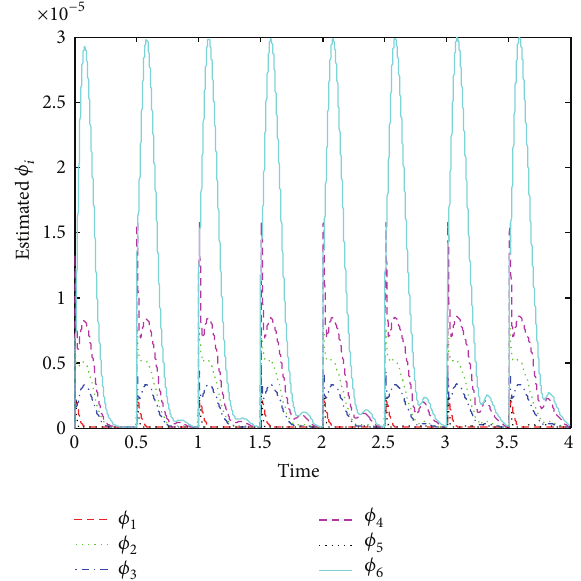
Figure 4: The evaluations of parameters 𝜙 𝑖 with 𝑖 = 1, ...,6 .